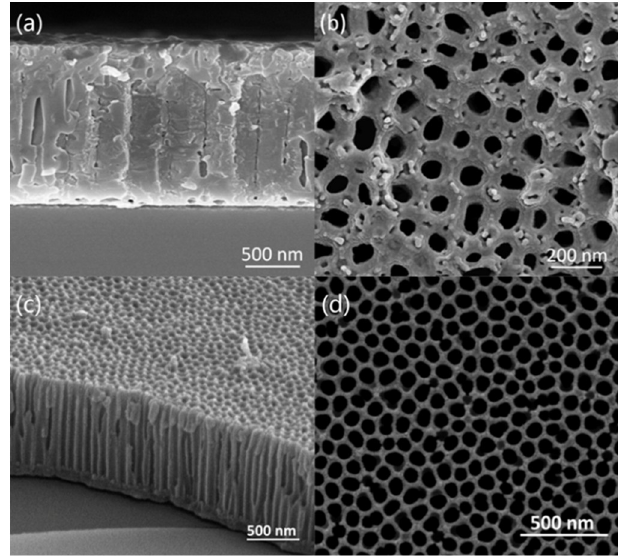
Figure 5. Field emission scanning electron microscopy (FESEM) images of the silicon‐based porous alumina film: ( a ) section, before pore enlarging; ( b ) surface, before pore enlarging; ( c ) section, after pore enlarging; ( d ) surface, after pore enlarging.